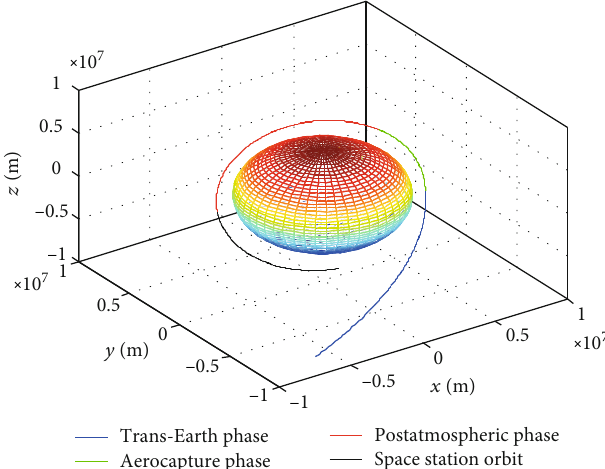
Figure 13: Three-dimensional demonstration of the three-phase trajectory near the